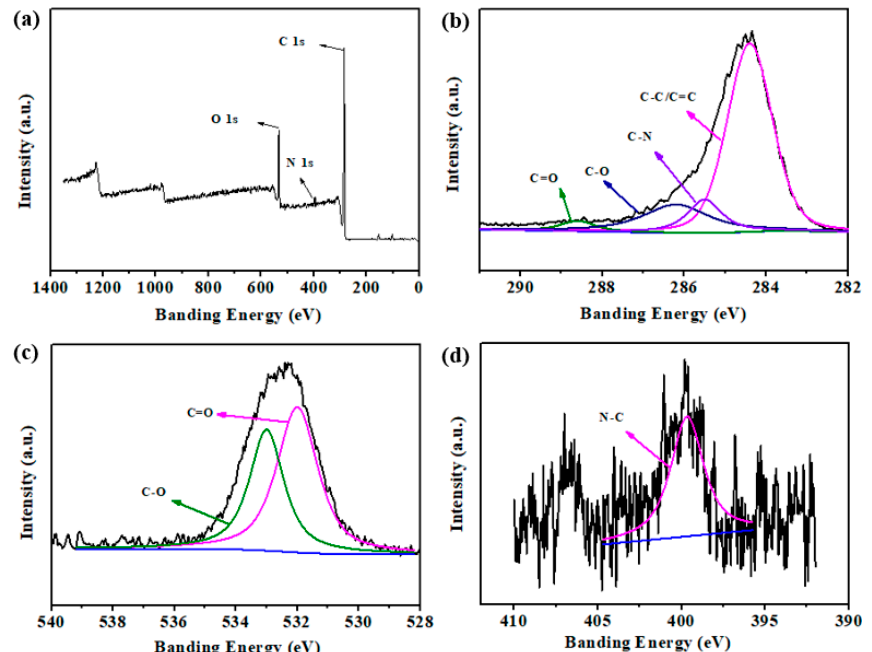
Figure 3. XPS wide scan spectrum of ( a ) N-L-CQDs; ( b ) high-resolution XPS spectra of C 1s; ( c ) O 1s; and ( d ) N 1s.